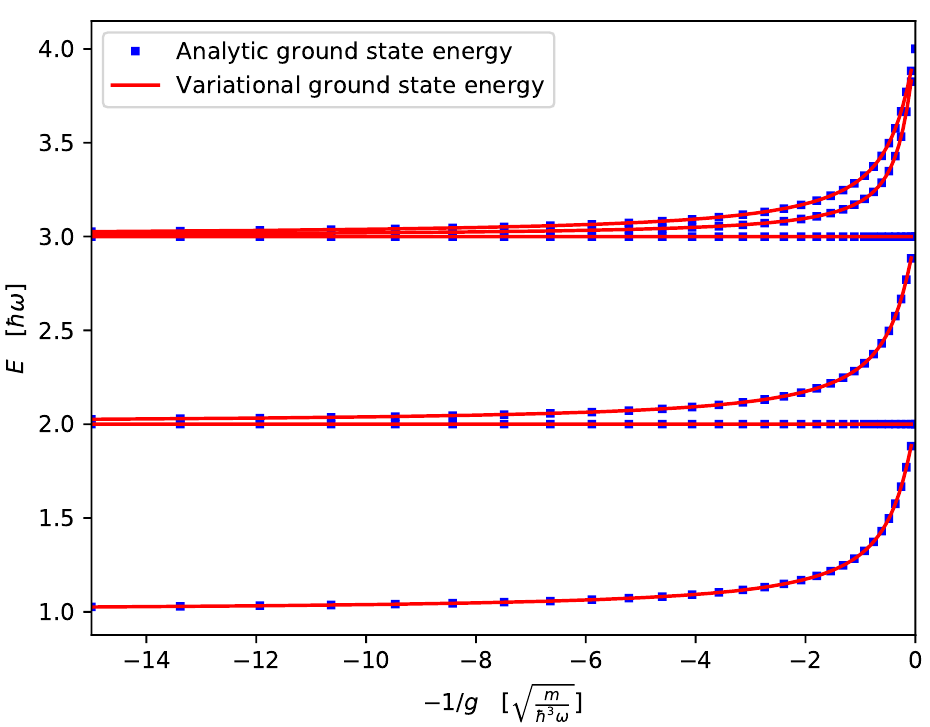
Figure 2: Energies for the lowest six states for the 1 + 1 system in a harmonic trap, computed both using the exact analytical method and the variational method.